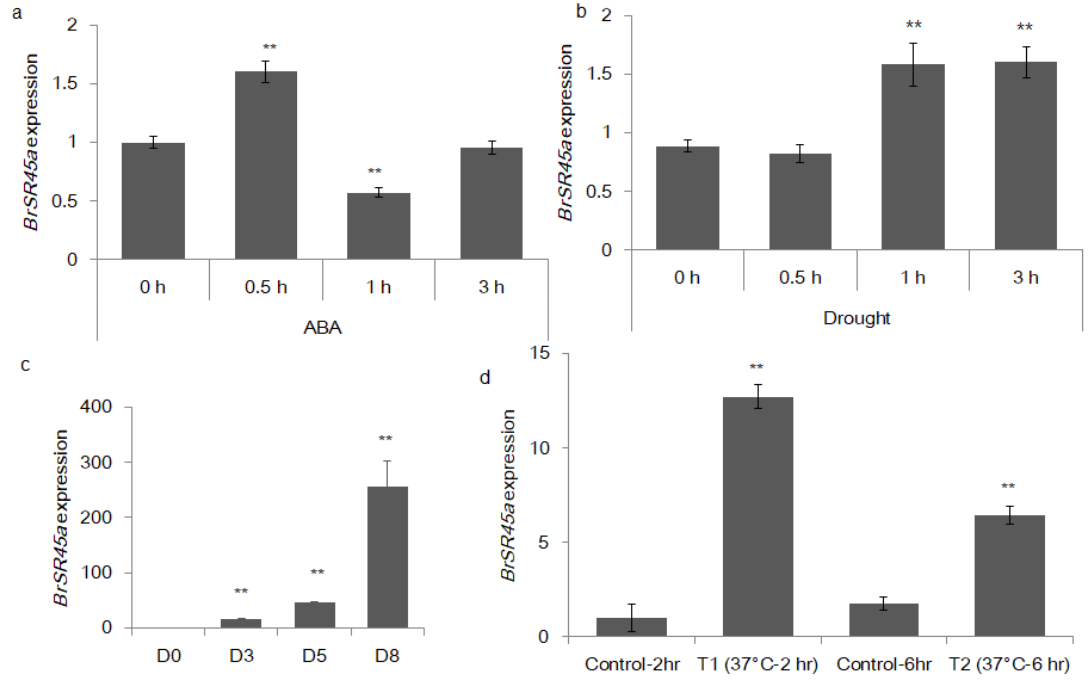
Figure 1. ABA, drought and heat stress affected the expression pattern of the B. rapa SR45a gene. The bar chart depicts the relative quantification of transcripts of BrSR45a during the exogenous application of ABA ( a ), drought ( b , c ) and heat stress ( d ), as measured using a quantitative RT-PCR assay; their expression was normalized to that of the B. rapa actin gene (** represents statistical significance). D0, D3, D5, and D8 represent the number of days plants were subjected to drought stress.